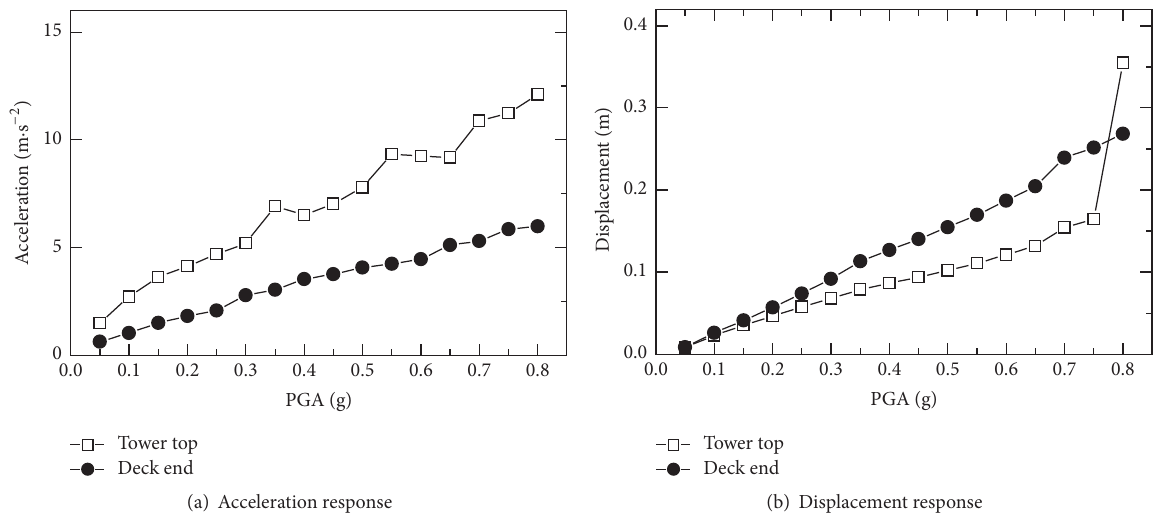
Figure 10: Measured peak acceleration and displacement response of the